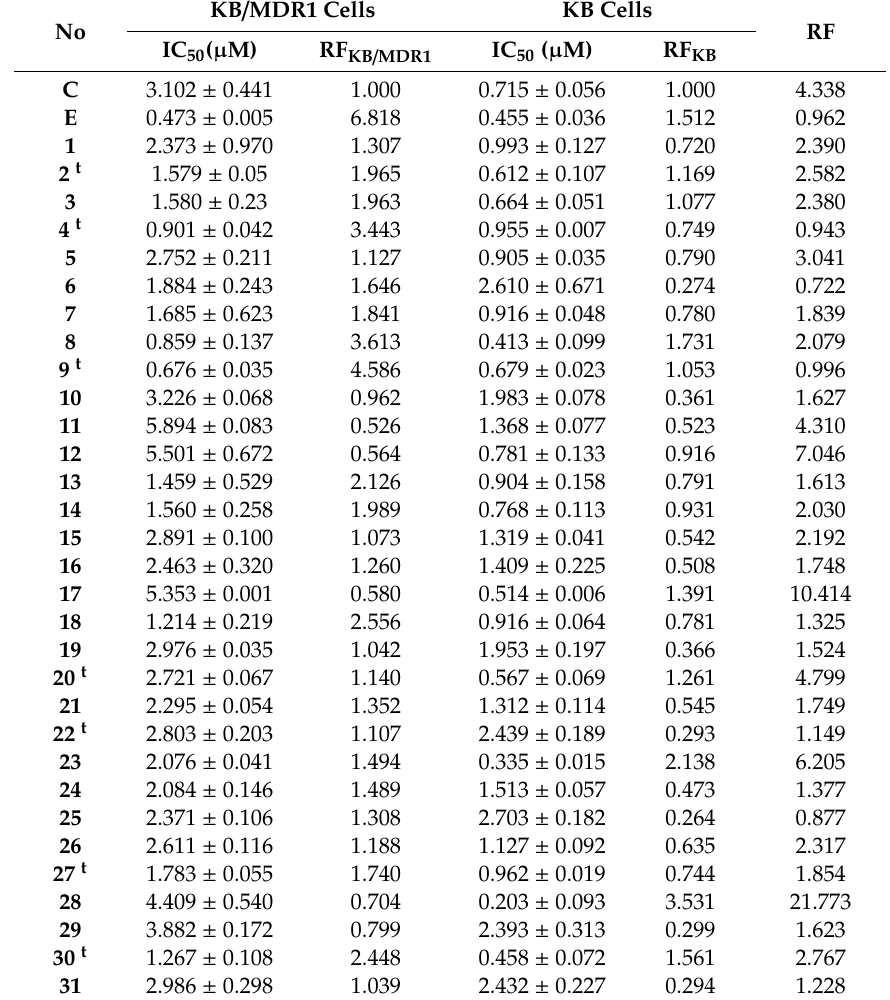
Table 2. Reversal e ff ect of flavonoids on the cytotoxicity of daunorubicin to KB / MDR1 and KB cell